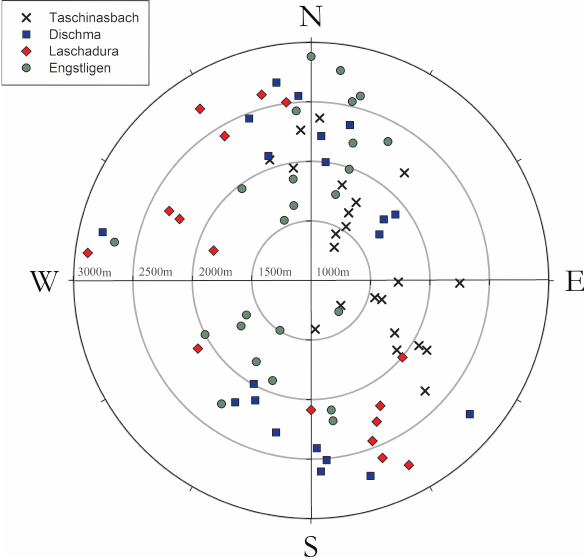
Fig. 2. Elevation and aspect of every sampled point of each